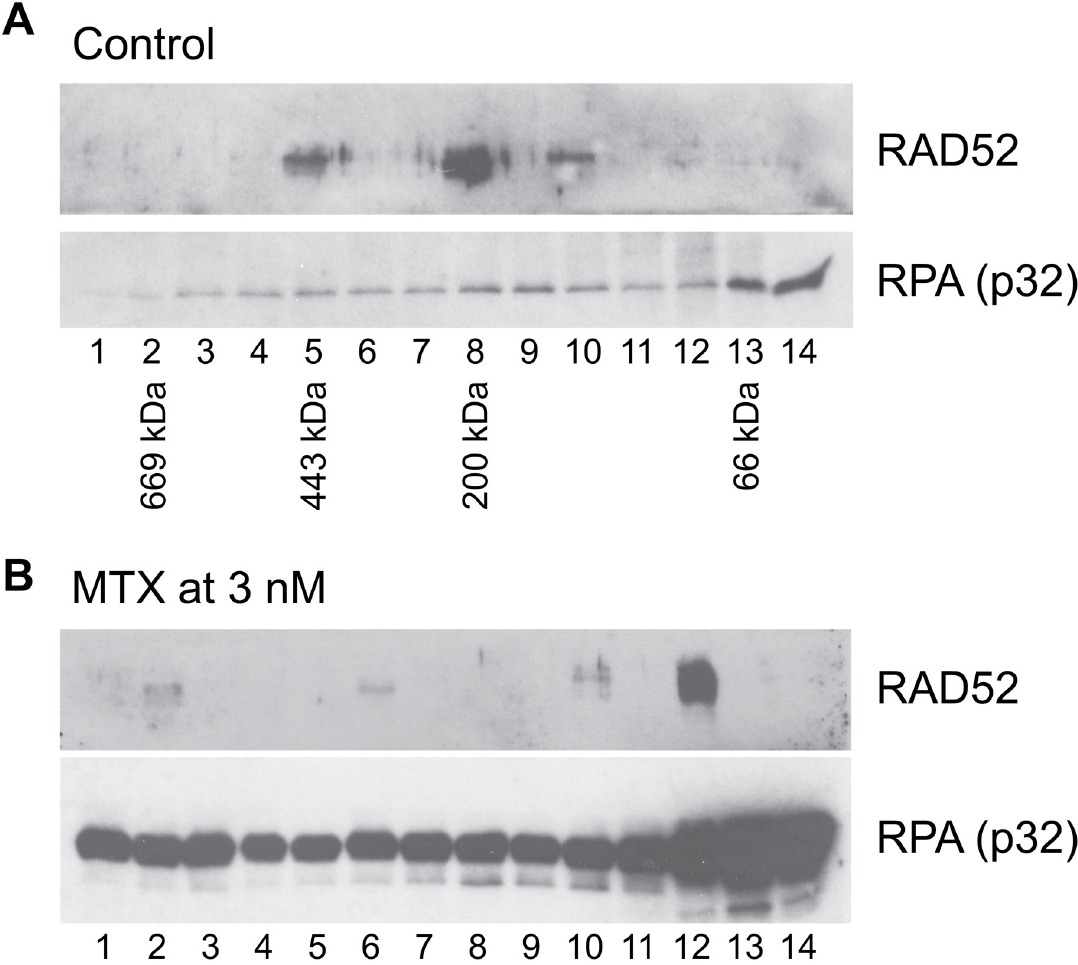
Fig 9. Mitoxantrone disrupts the RPA:RAD52 PPI in cells. (A) RAD52 was co-immunoprecipitated with RPA in the fractions 5, 8, and 10 in the control experiment. The elution positions of the molecular weight standards, thyroglobulin (669 kDa), apoferritin (443 kDa), beta-amylase (200 kDa), and bovine serum albumin (66 kDa), are indicated below the western blot. The data indicate that RAD52 and RPA were in complexes with sizes of ~400 kDa and ~200 kDa in the control. (B) The treatment of the cells with 3 nM mitoxantrone resulted in the loss of the co-immunoprecipitation of RAD52 with RPA in the large complexex. These data suggest that mitoxantrone disrupted the interaction of RAD52 and RPA in cells.